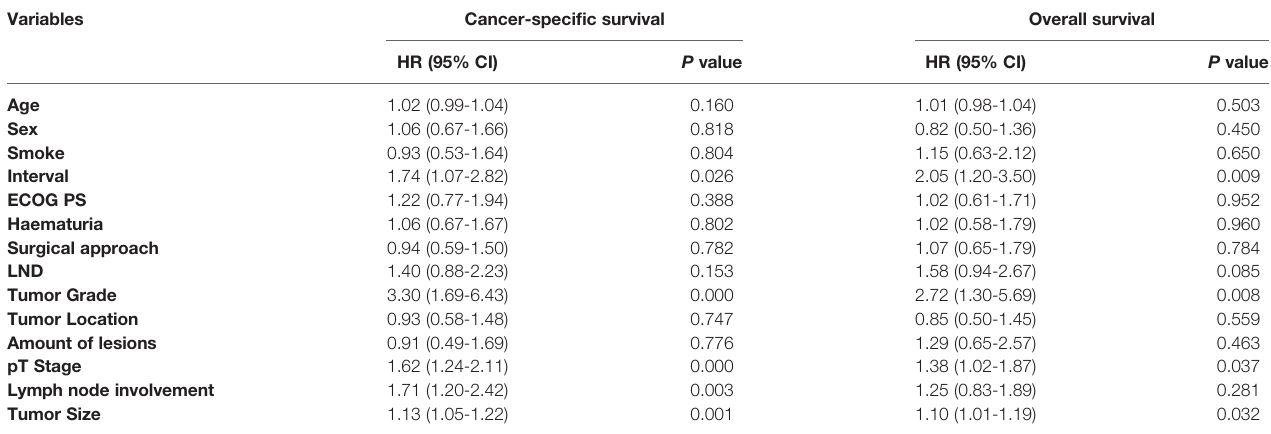
TABLE 3 | Multivariable Cox model for cancer-speci fi c survival and overall survival.